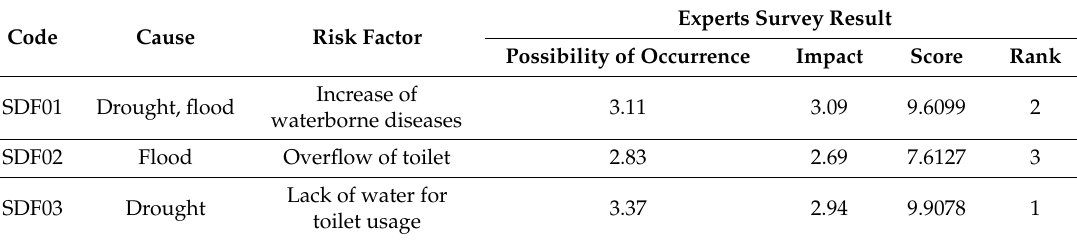
Table A5. SDF risk factors and assessment result of Kurunegala.